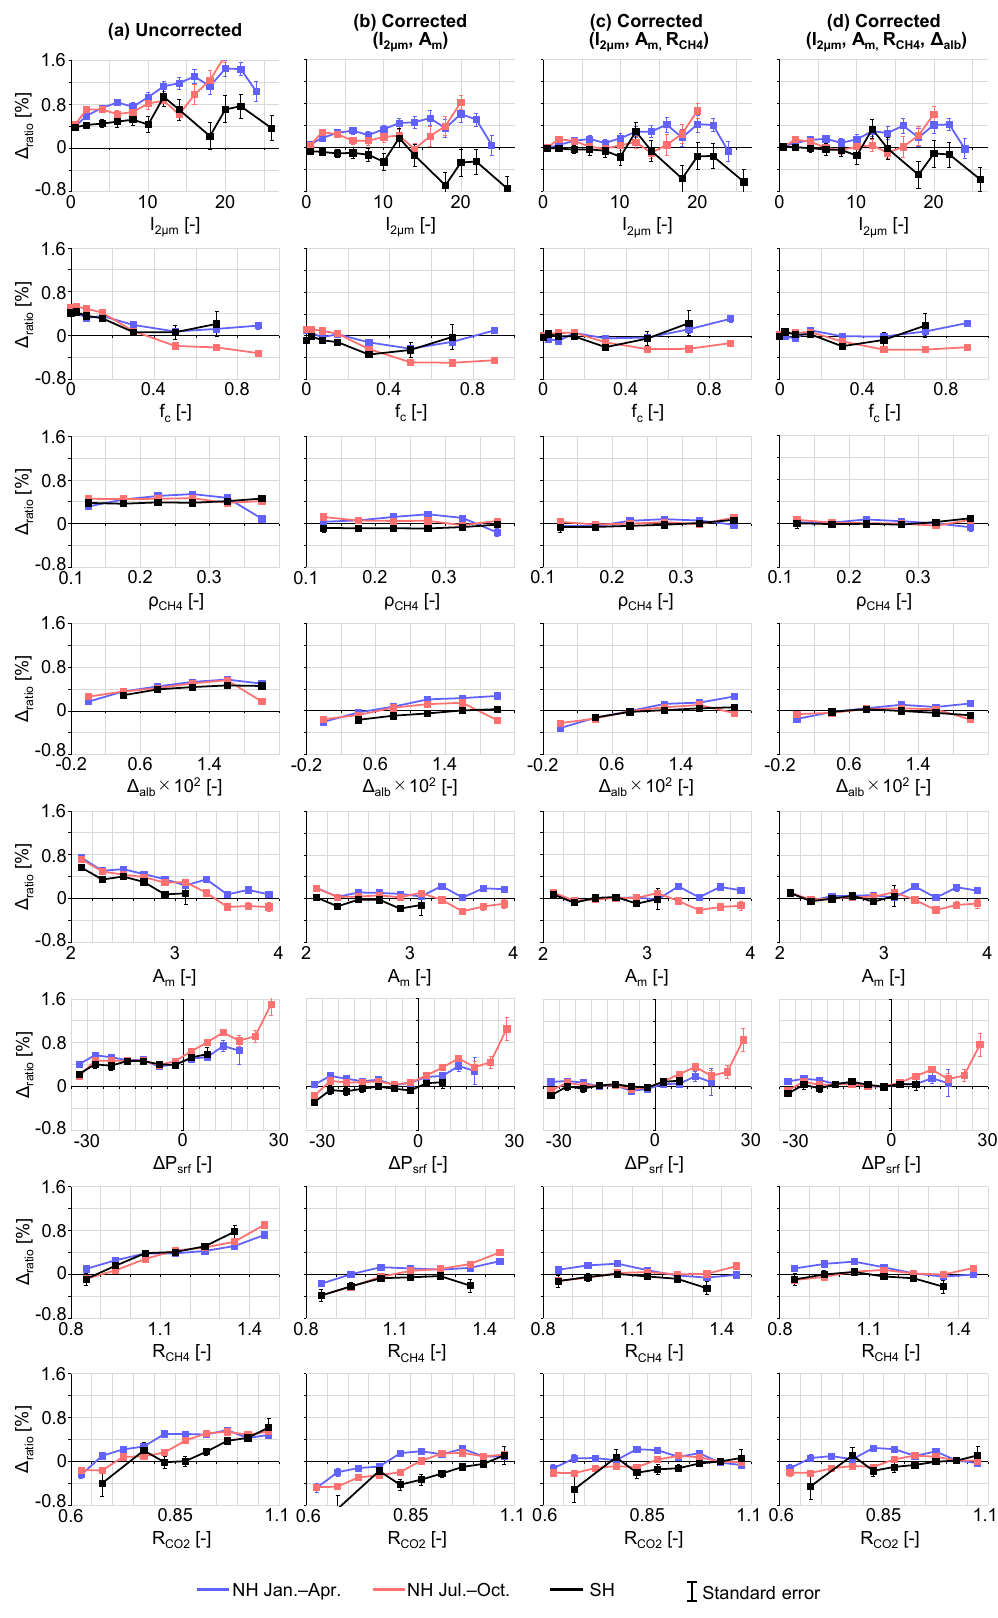
Figure 7. Variation of the relative di ff erence in the ratio component between GOSAT and TCCON ( ∆ ratio ) according to the explanatory variables: normalized 2 µ m band radiance (I 2 µ m ); cloud